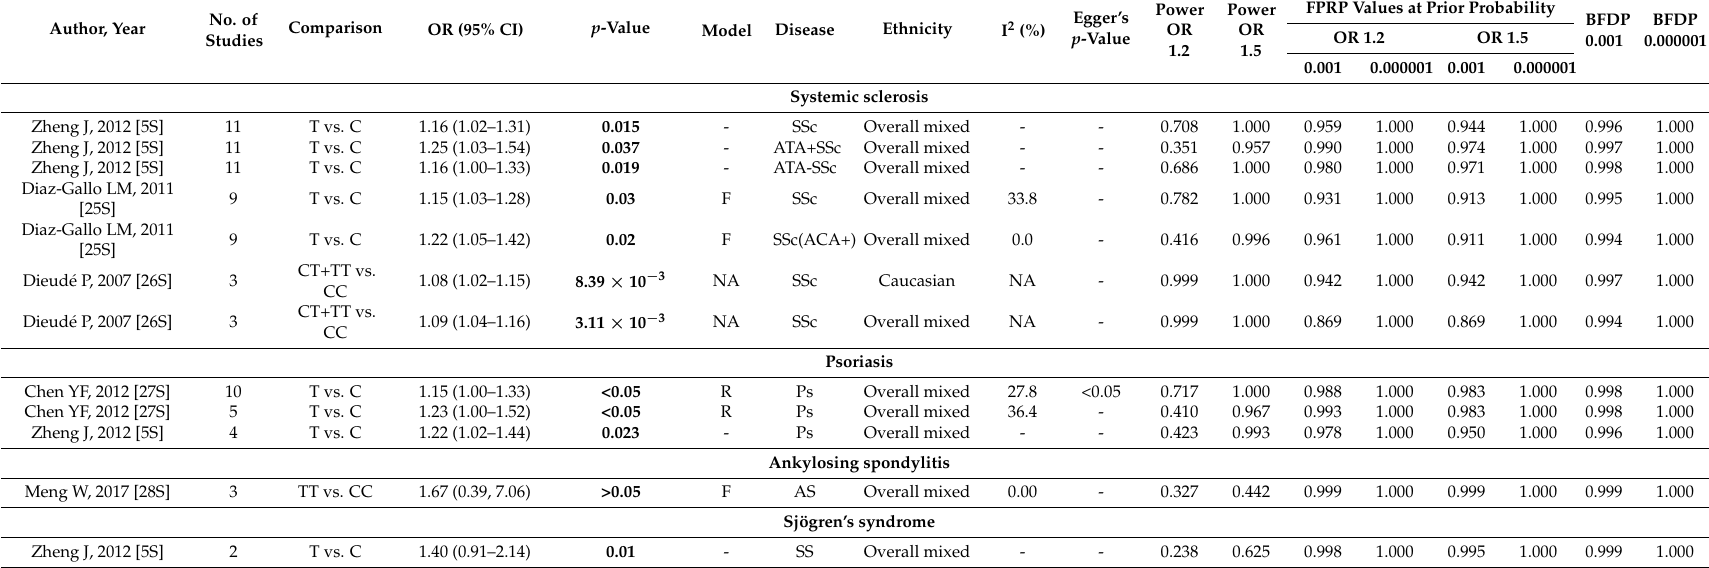
Table 5. Meta-analysis results of associations between other rheumatic diseases and the PTPN22 1858 C/T polymorphism from observational